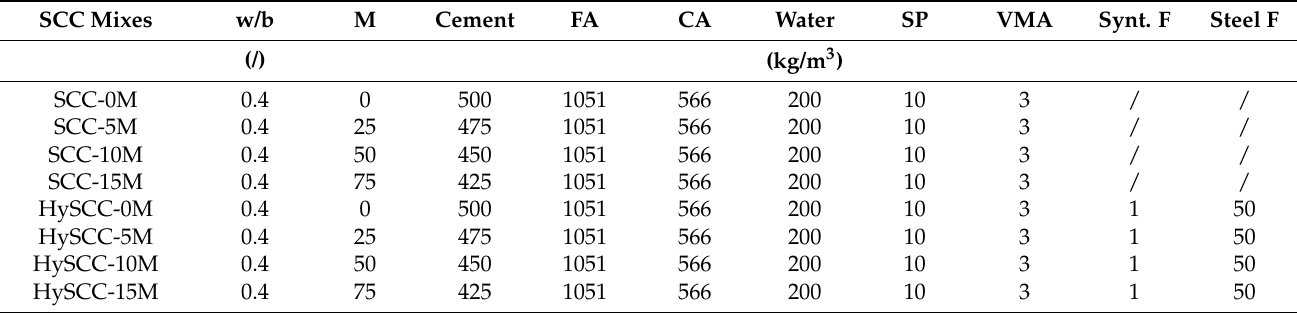
Table 2. Detailed proportions of the SCC